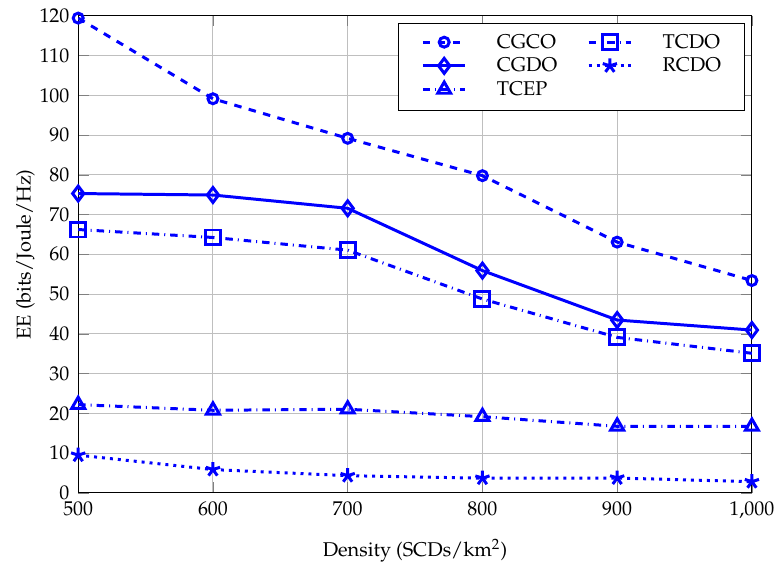
Figure 6. The changes in the EE of the methods in different